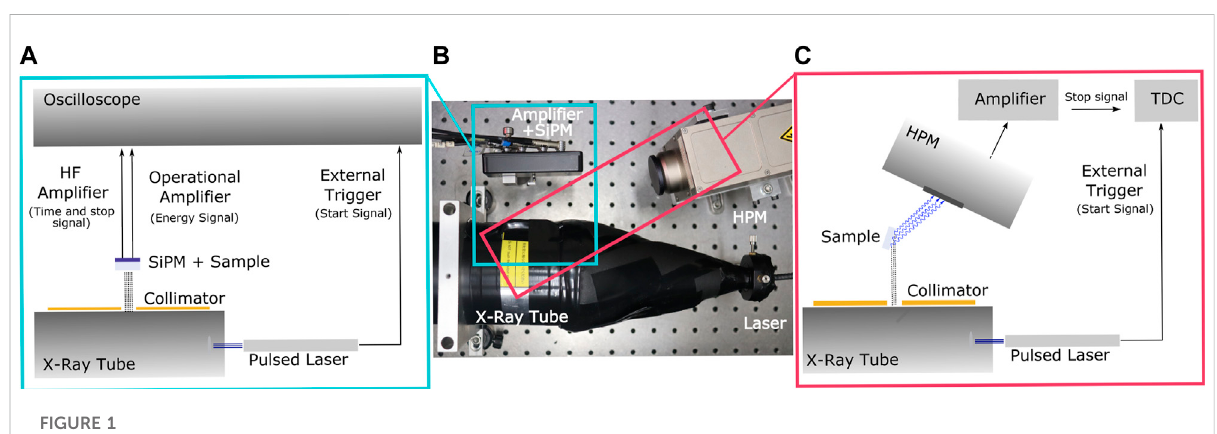
FIGURE 1 Schematic drawing of the X-ray detector time resolution and light output bench (A) and of the time-correlated single-photon counting bench for rise and decay time measurements (C) . Picture of the two coexisting setups is also shown (B)